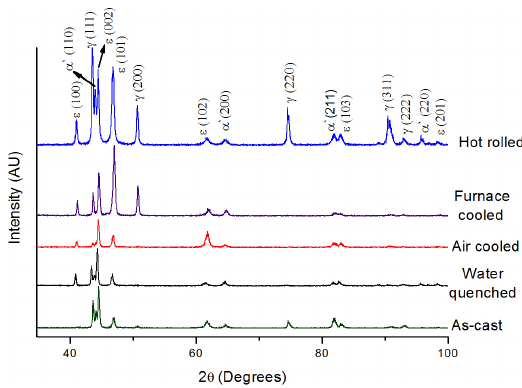
Figure 1. X-ray diffractograms after different processing conditions of the steel.